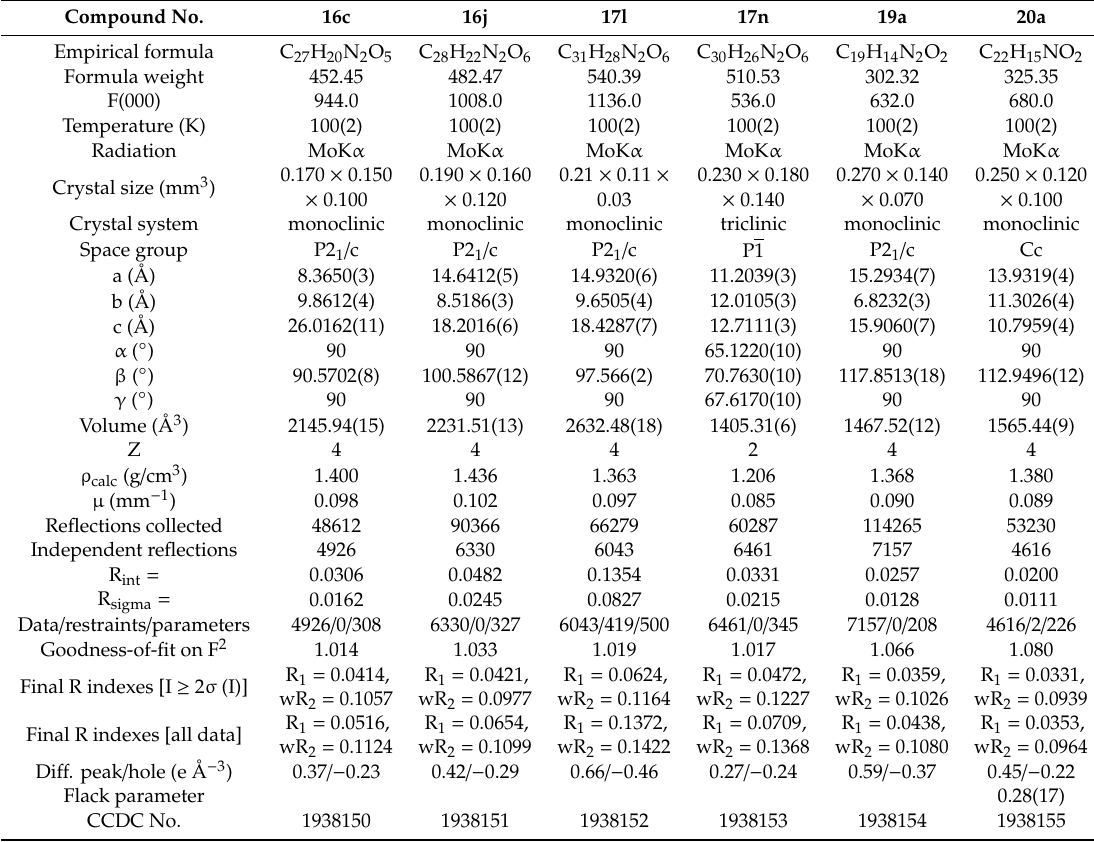
Table 5. Crystal Data and Structure Refinement Parameters for compounds 16c , 16j , 17l , 17n , 19a and 20a .